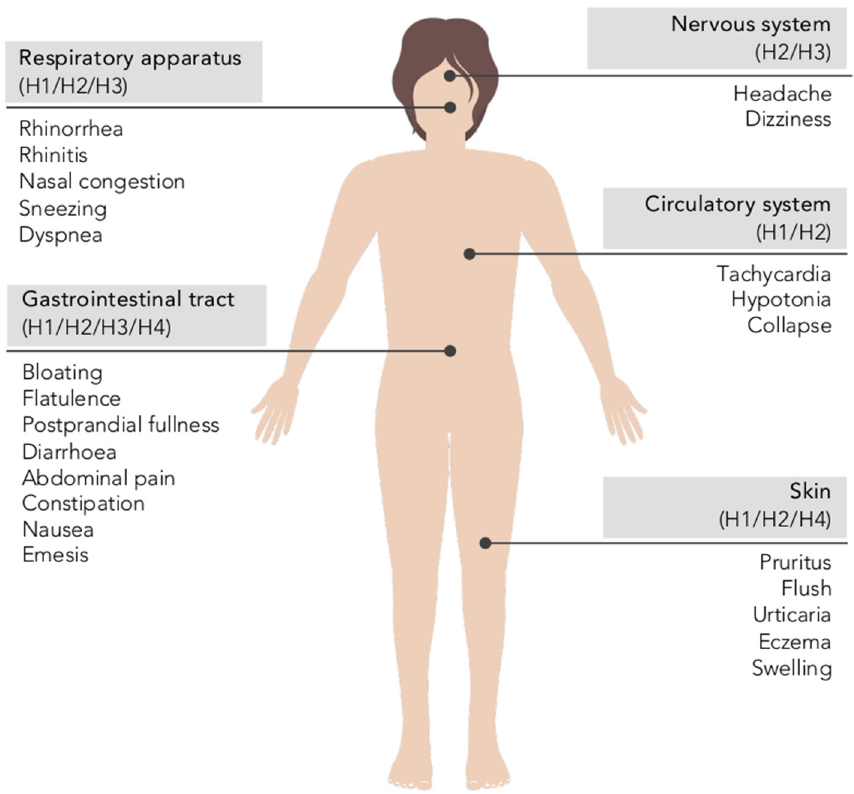
Figure 6. Main symptoms of histamine intolerance and possibly corresponding histamine receptors [10,64].